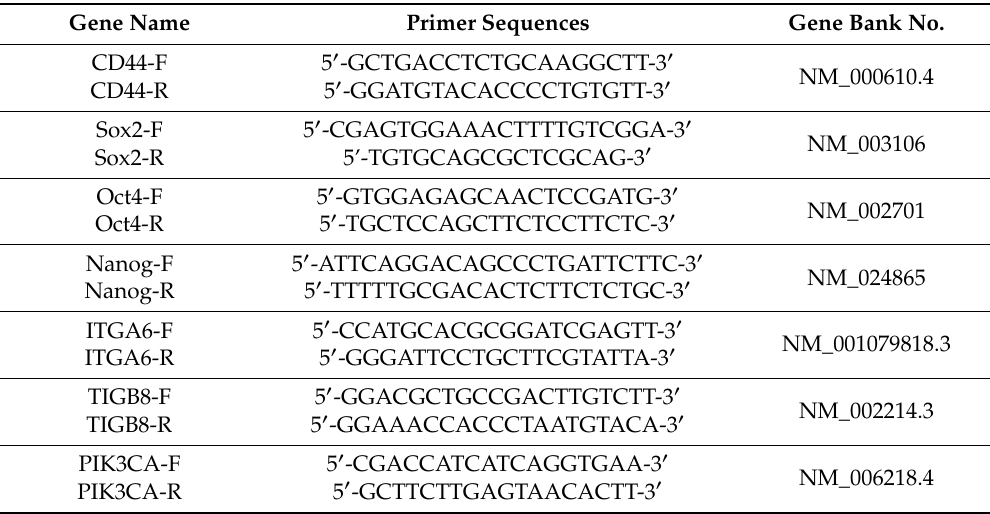
Table 1. The primers used for